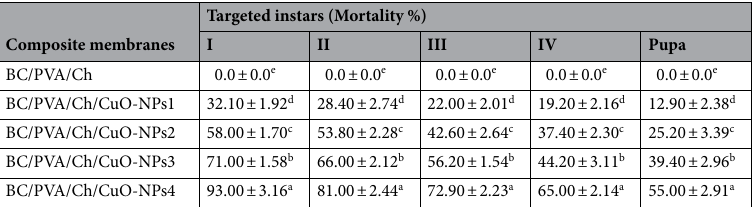
Table 5. Larvicidal and Pupicidal activity of BC/PVA/Ch composite with four different concentrations of CuO-NPs against A. aegypti mosquito. All values were expressed as Mean ± standard deviation. Different letters indicate significant difference, which are arranged in ascending order within the same column at P < 0.05: a > b > c > d > e.